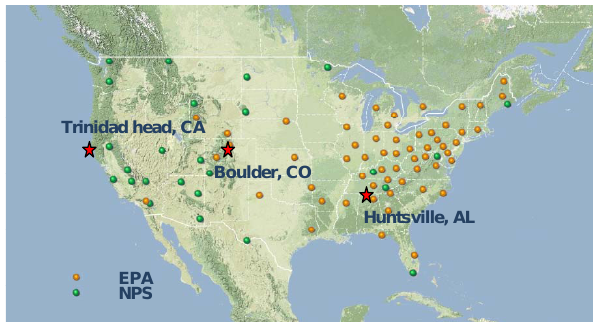
Fig. 3. The CONUS domain with observation sites marked in green Fig. 2. The CONUS domain with observation sites marked in green or orange from or orange from CASTNET and ozonesondes in red star. CASTNET and ozonesondes in red star.